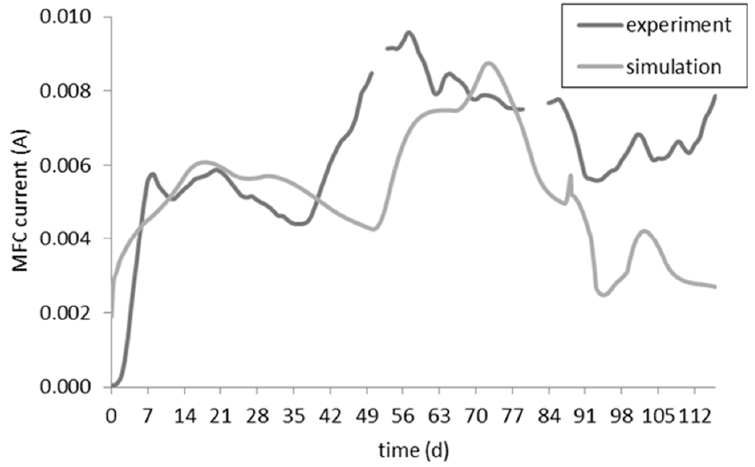
Figure 5. Simulated vs. observed current production by the cell.